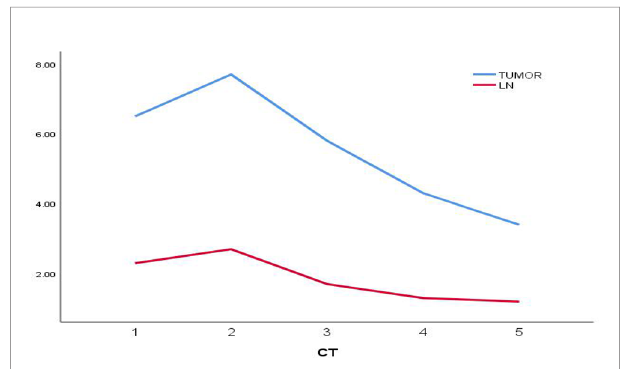
FIGURE 3 | The evariation trend of the size of the tumor and the mediastinal lymph